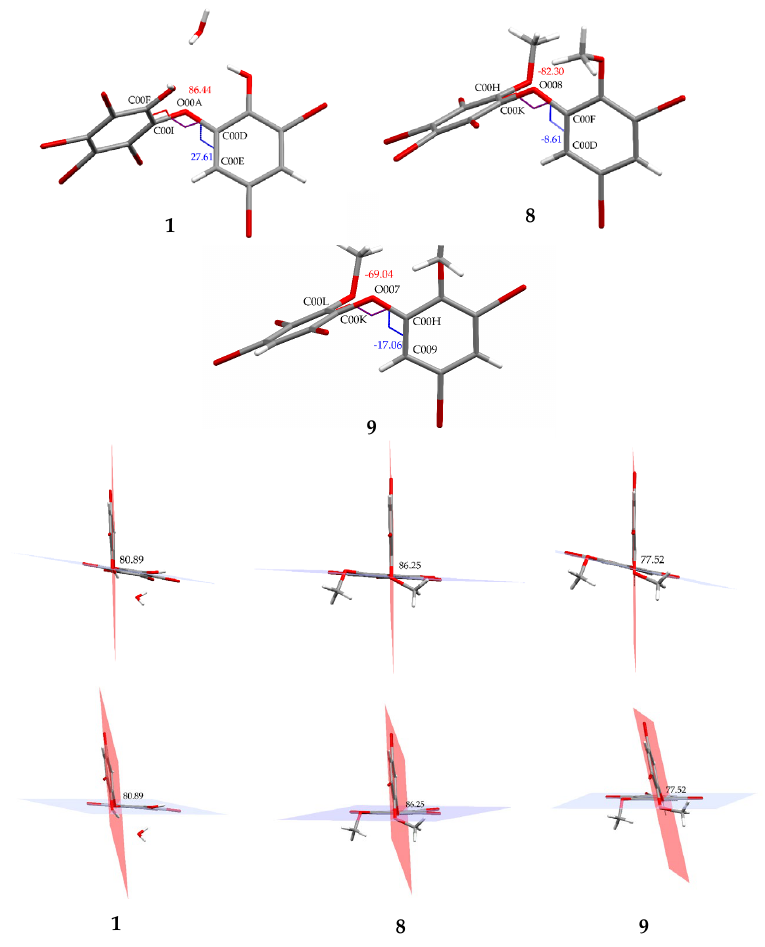
Figure 3. Crystal structures of 1 , 8 and 9 with displacement ellipsoids drawn at the 50% probability level. The crystal structure of 1 is presented to compare the material for structure modification with two phenolic groups and debromination.